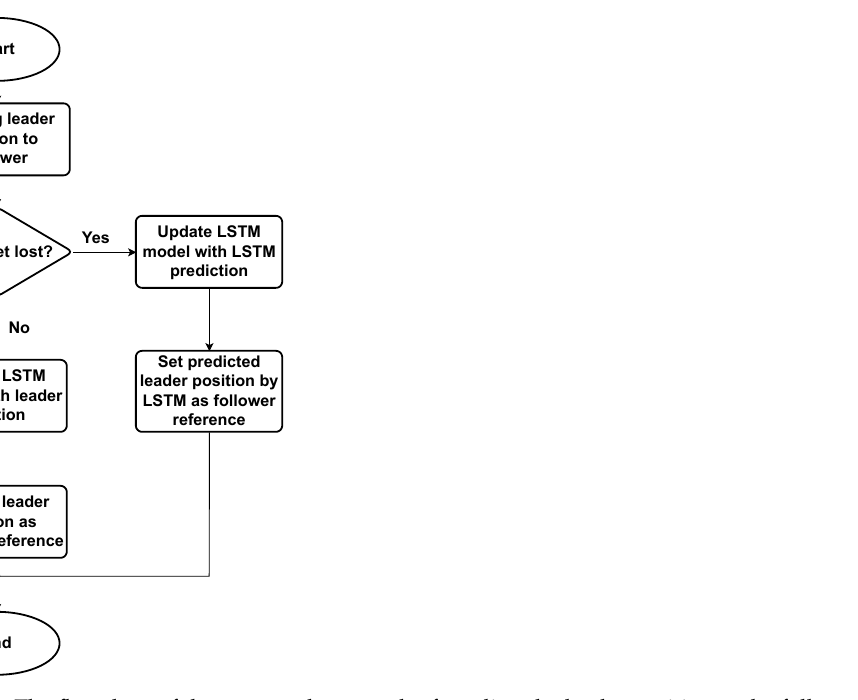
Figure 5. The flowchart of the proposed approach of sending the leader position to the